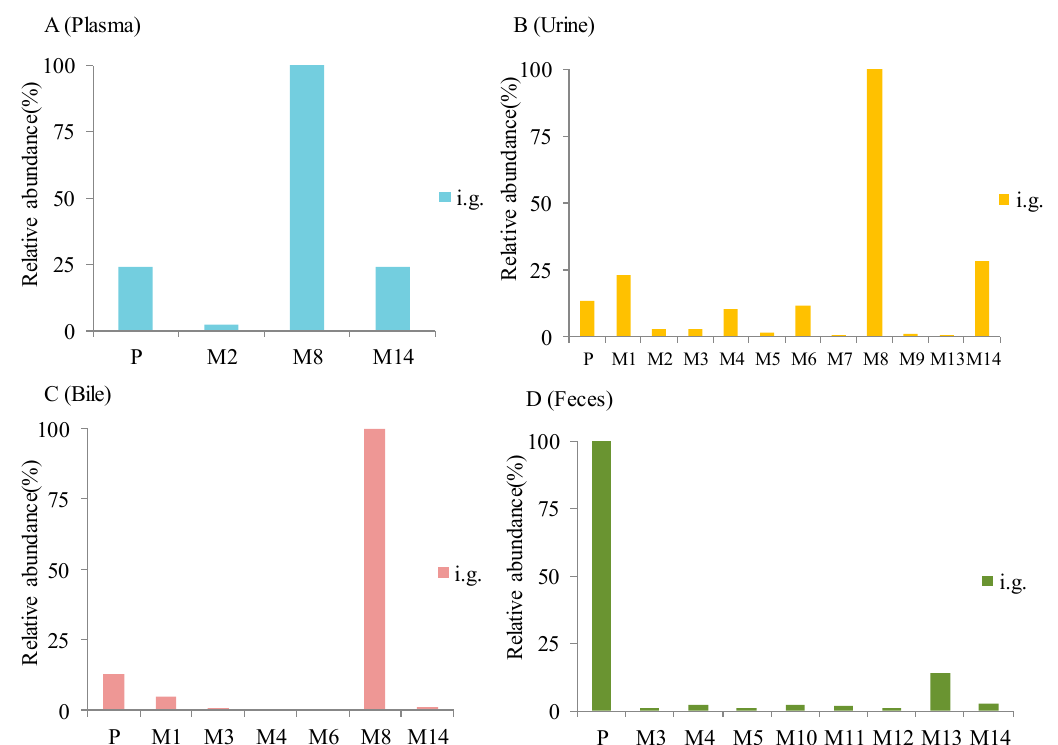
Figure 2. Metabolite profile in plasma ( A ), urine ( B ), bile ( C ), and feces ( D ) after administration of alpinetin. Relative abundances are expressed by the percentage of MS response with the most abundant compound being 100.